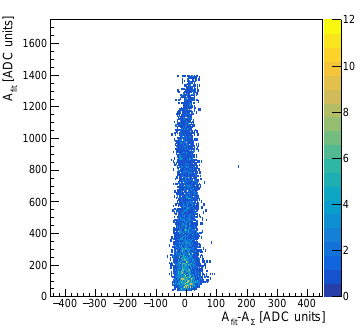
Figure 6: Correlation between A fit − A Σ and A fit